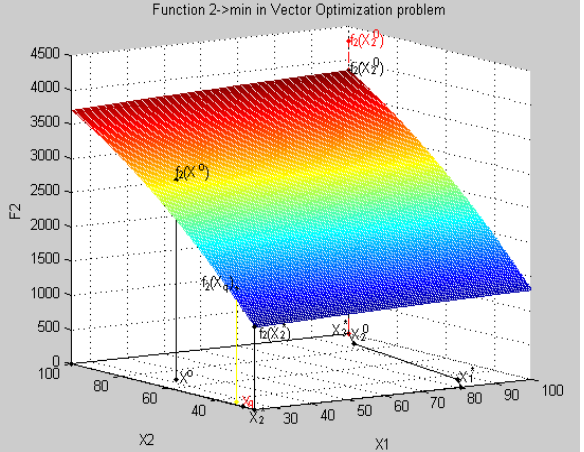
Figure 10. The second characteristic f 2 ( X ) of the technical system in a natural indicator.